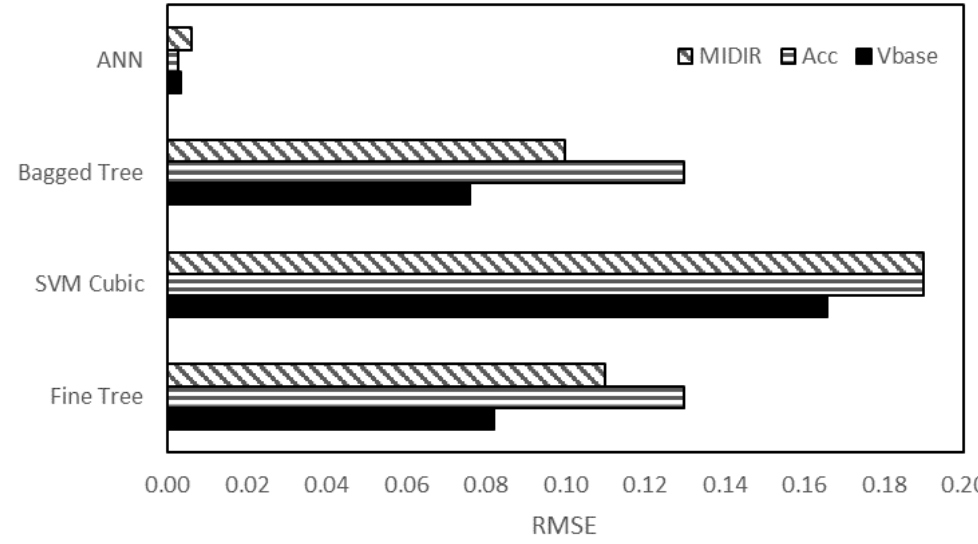
Figure 11. Comparison of RMSE values of SVMs and ANN.